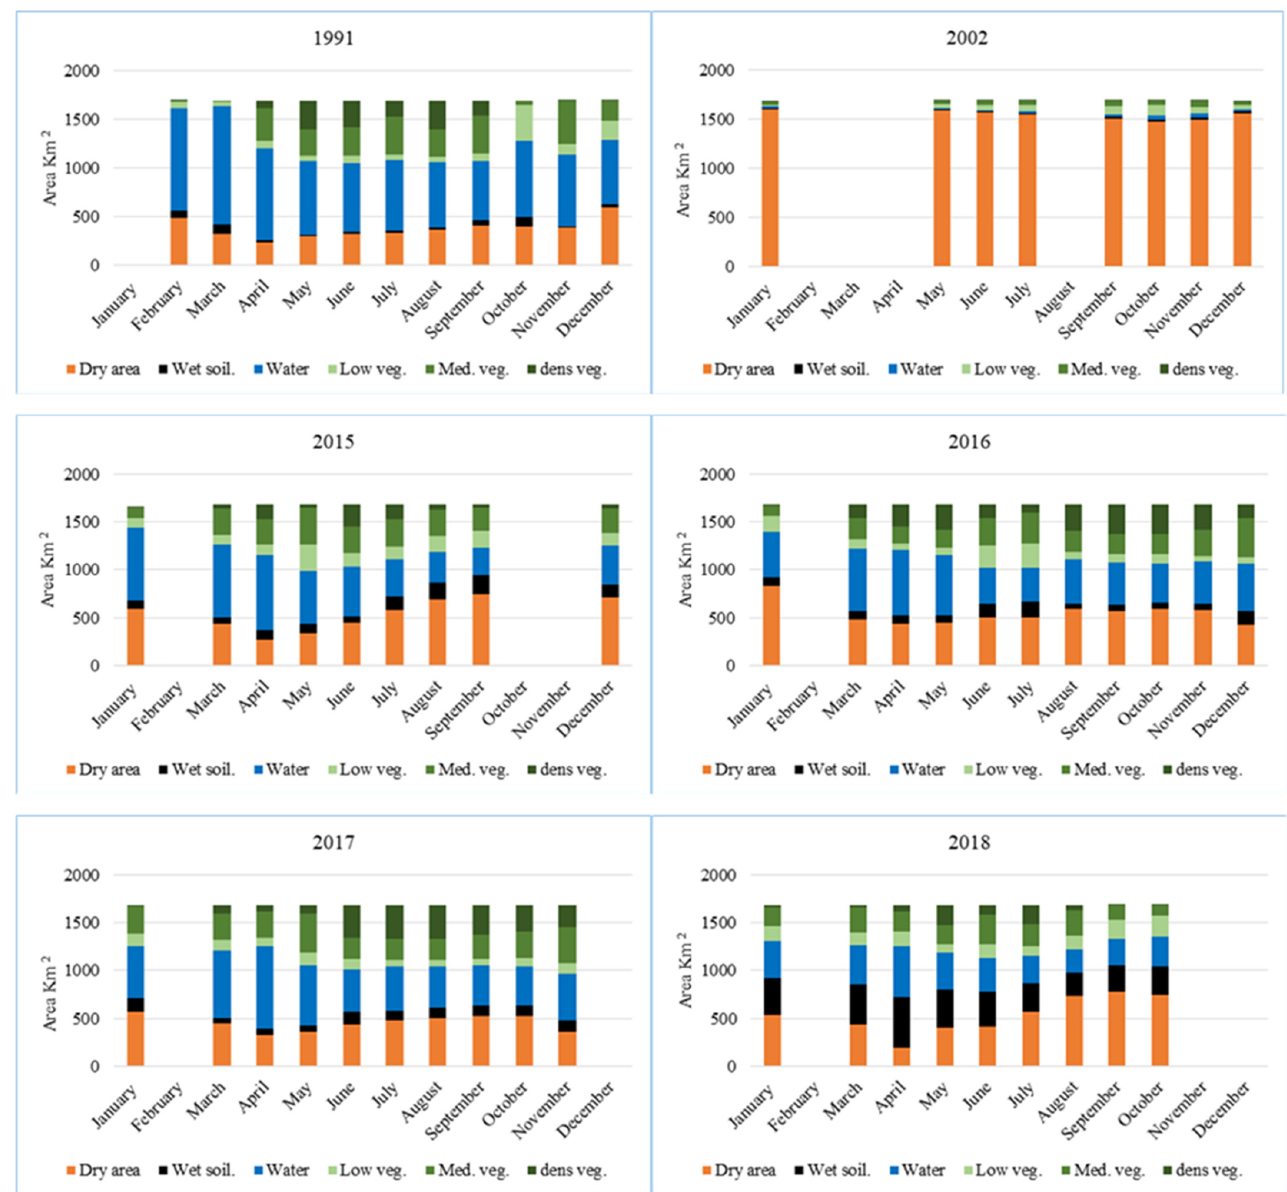
Figure 9. Monthly changes in vegetation type and water cover areas in the Al Hammar marshland: comparison between 1991, 2002, 2015, 2016, 2017, and 2018.